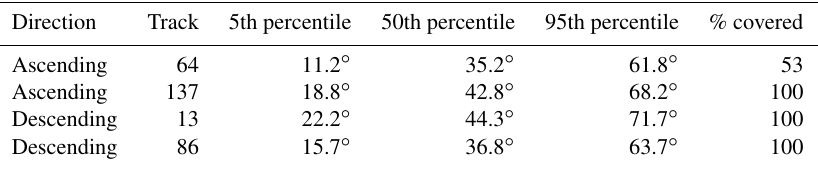
Table 1. Sentinel-1 SAR orbit tracks over the La Joie Basin. Percentiles for average local incidence angles for each track are displayed, as well as the area covered by that track (calculated as a percent of the total basin area). Direction Track